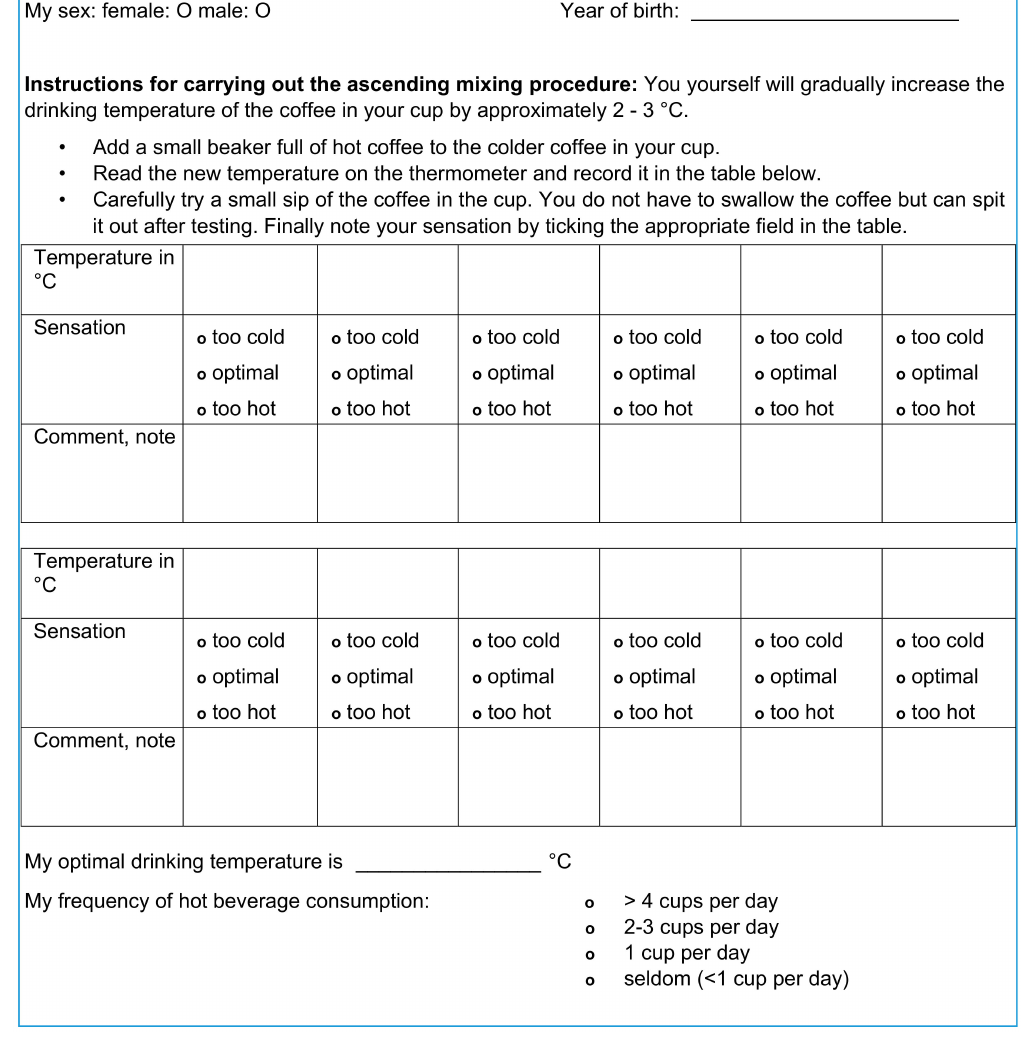
Figure A2. Experimental sheet for each participant of the trial (English